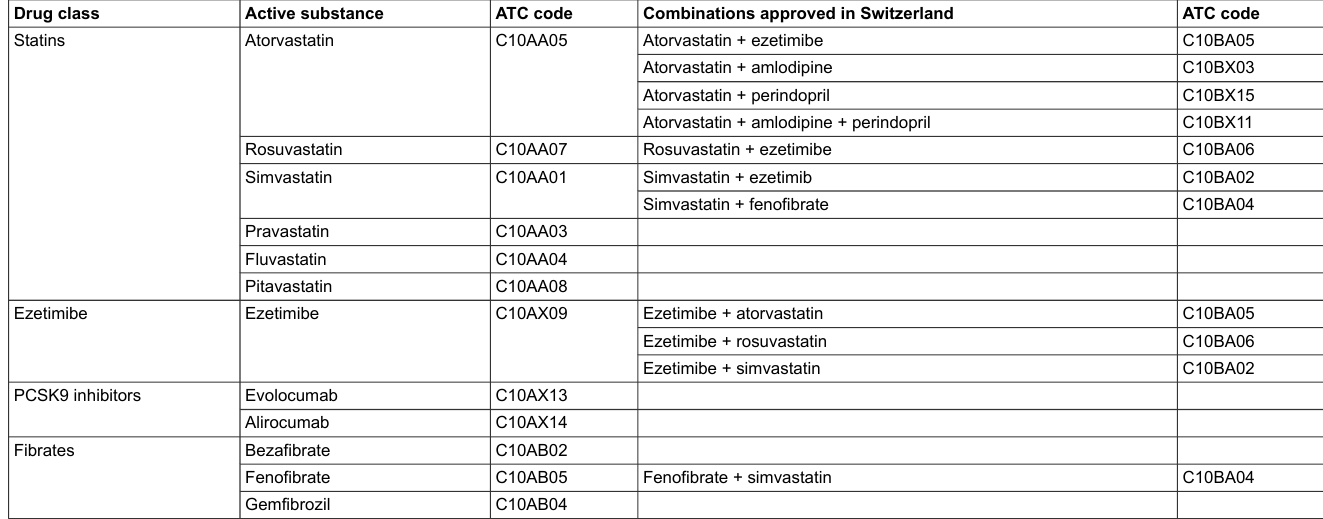
Table 1: Lipid-lowering drug classes and active substances with anatomical therapeutic chemical (ATC) classification system codes.